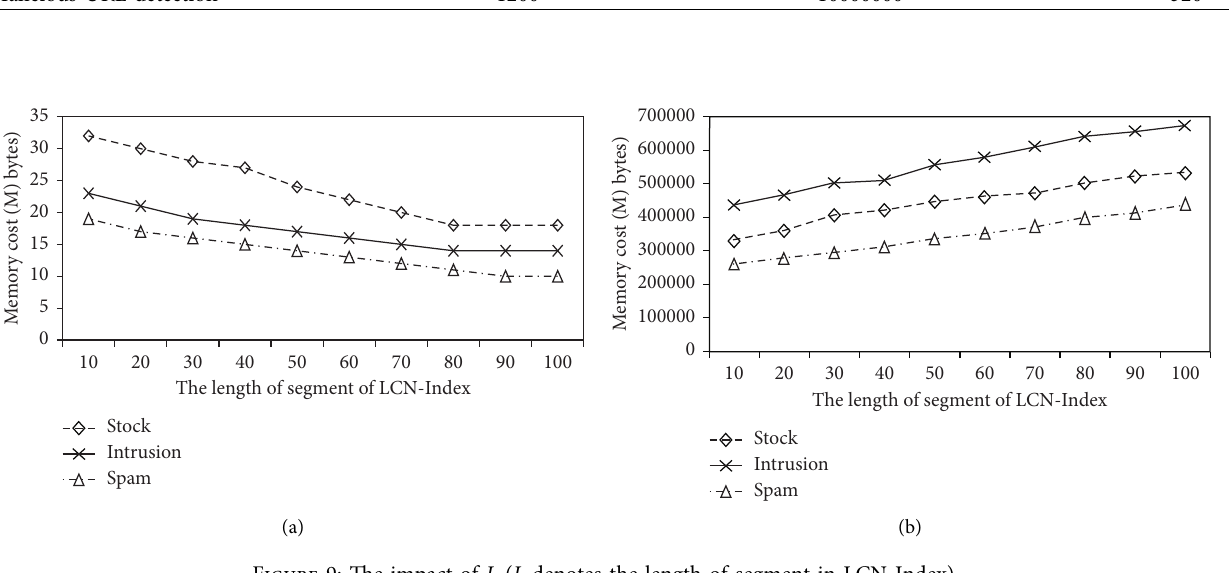
Figure 9: The impact of L ( L denotes the length of segment in LCN-Index).